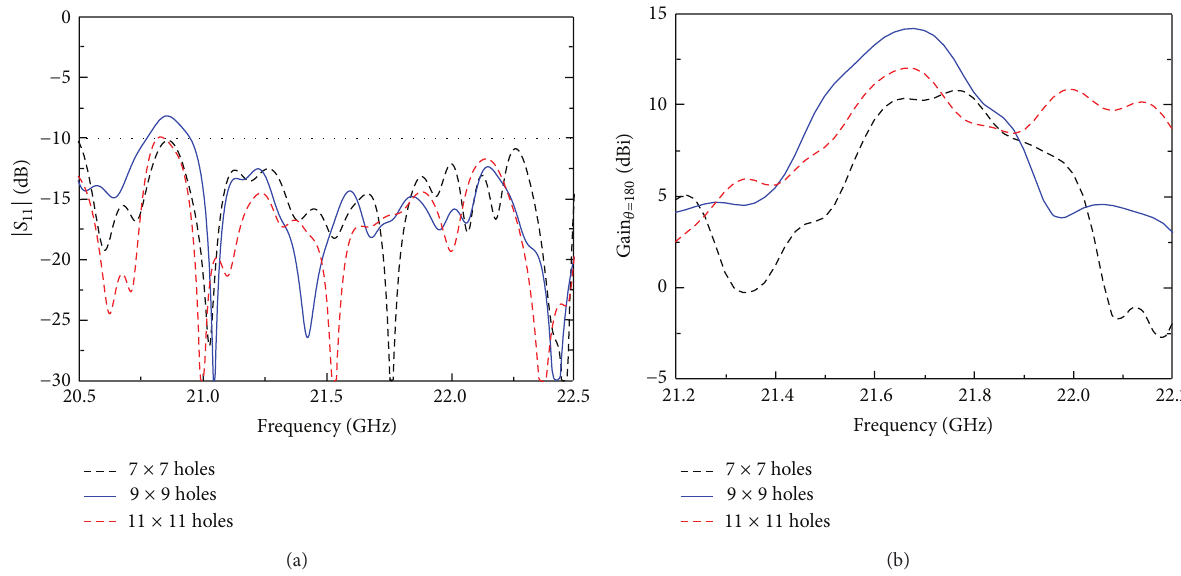
Figure 7: Effect of the number of holes on antenna characteristics with respect to (a) the reflection coefficient and (b) boresight gain.